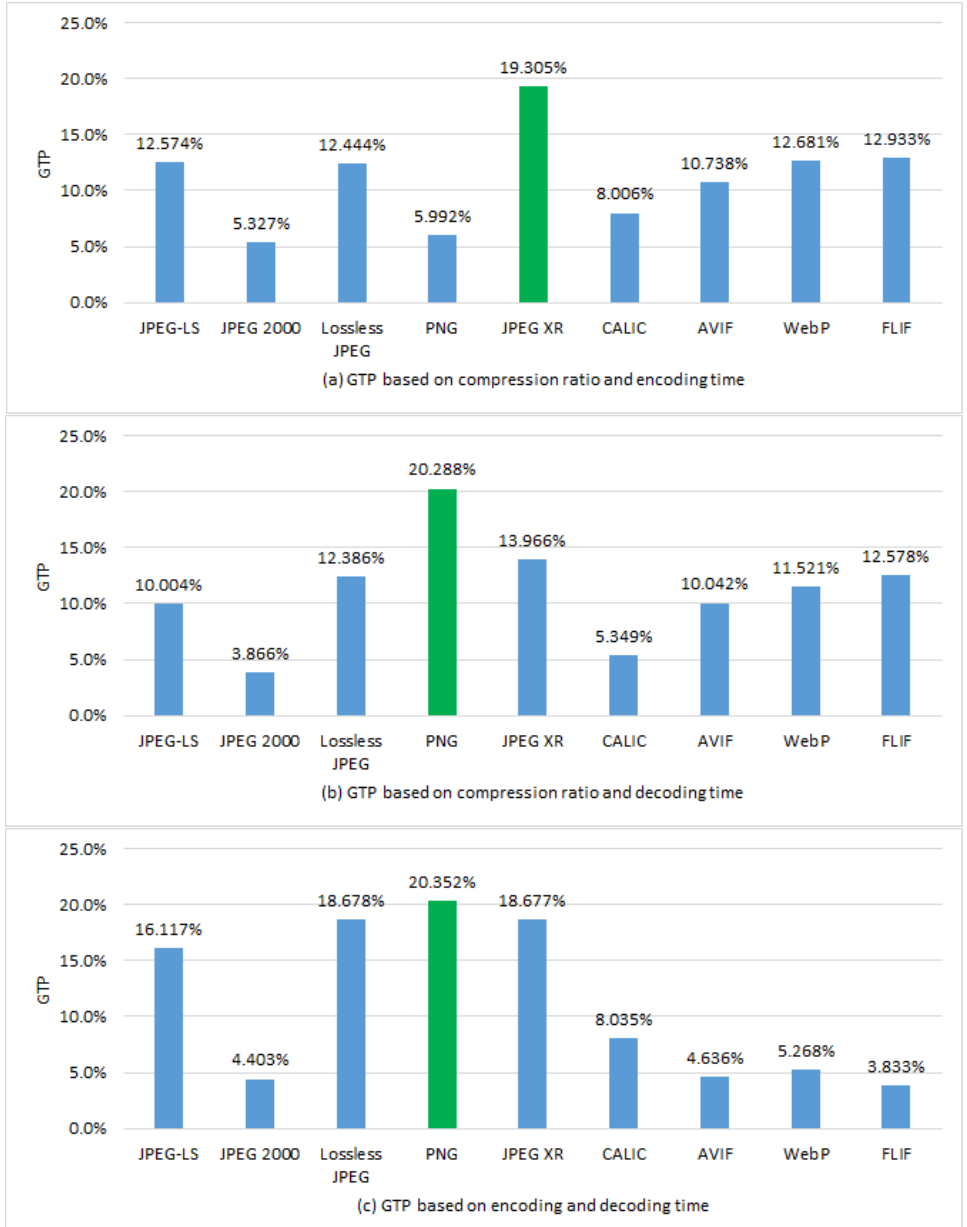
Figure 31. Two-parameter GTP for 16-bit greyscale